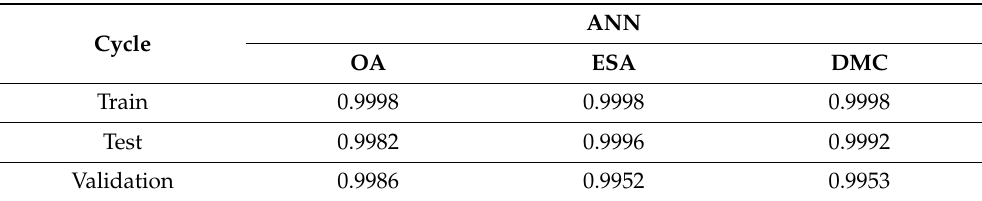
Table 4. Coefficients of determination (r 2 ) between experimentally measured and ANN outputs, during training, testing, and validation steps.